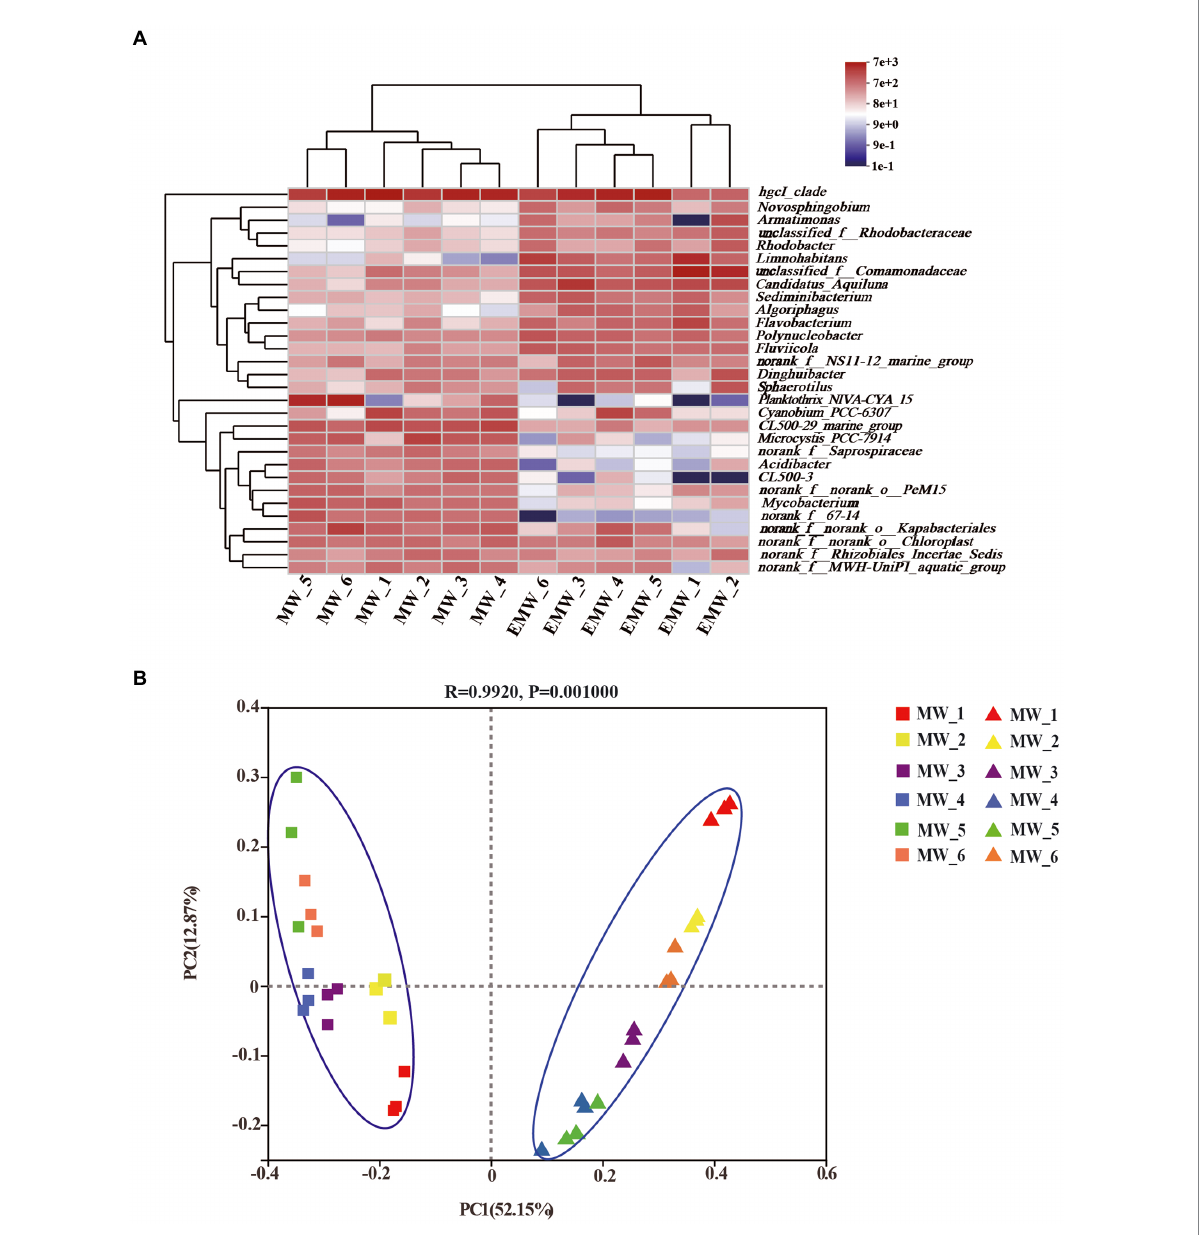
FIGURE 6 Microbial community analysis at the genus level. (A) Heatmap of the relative abundance. (B) PCoA